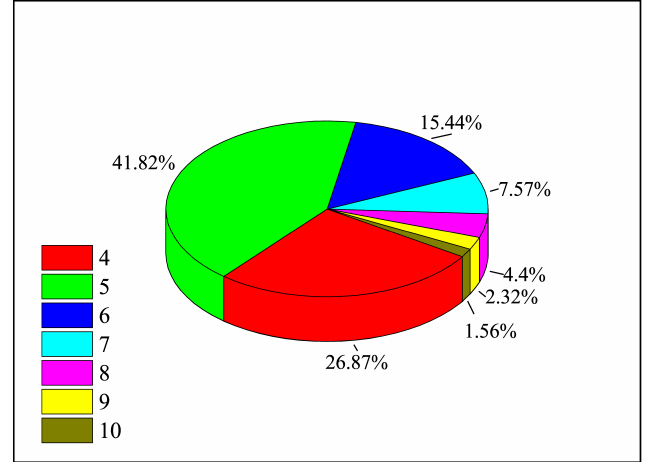
Figure 9. The proportions of nl ( n = 4 − 10) energy levels to the total cross-section in EA processes of the ground state W 43 + .